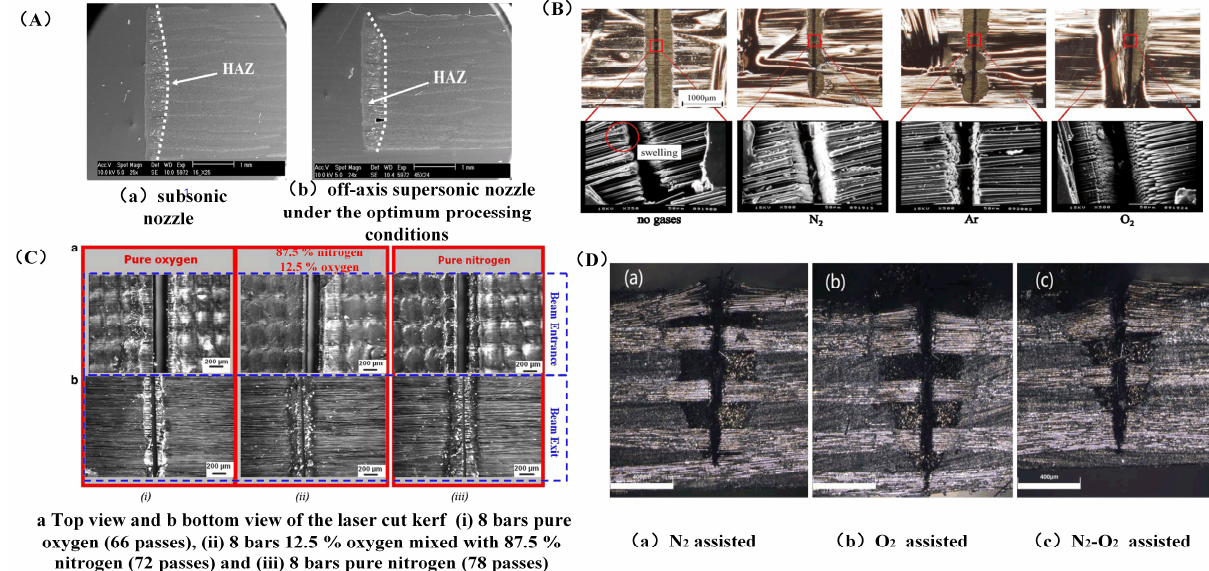
Figure 14. Effect of different auxiliary gases on laser processing of CFRP: ( A ) two different kinds of nozzle processing [97]; ( B ) cross-section view of different gas processing CFRP sample processes [98]; ( C ) the effect of gas processing with different contents [99]; ( D ) different gas processing [100].